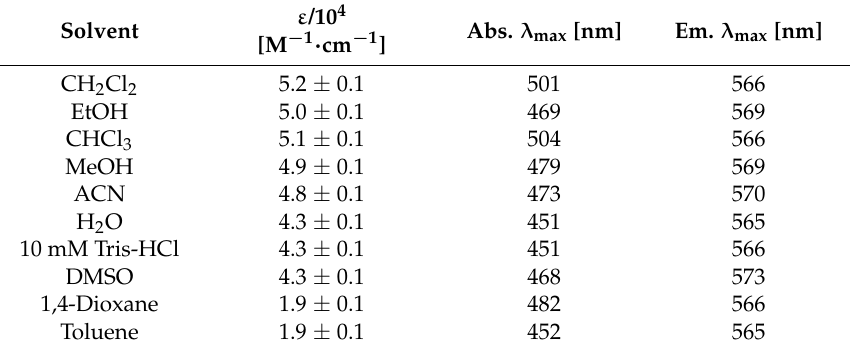
Table 1. Effect of solvent on the spectral parameters in the absorption and fluorescence spectra of ligand 3 (mean values ± standard deviation (SD) of three